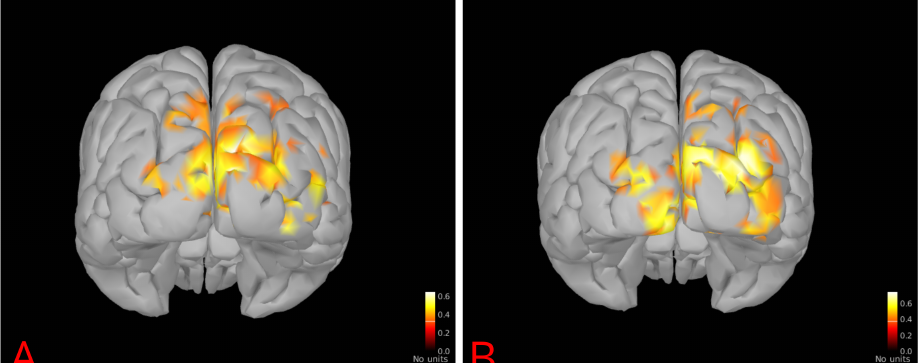
Figure 4. Typical cortical distributions of event-related coherence for ( A ) Subject 2 (low noise) and